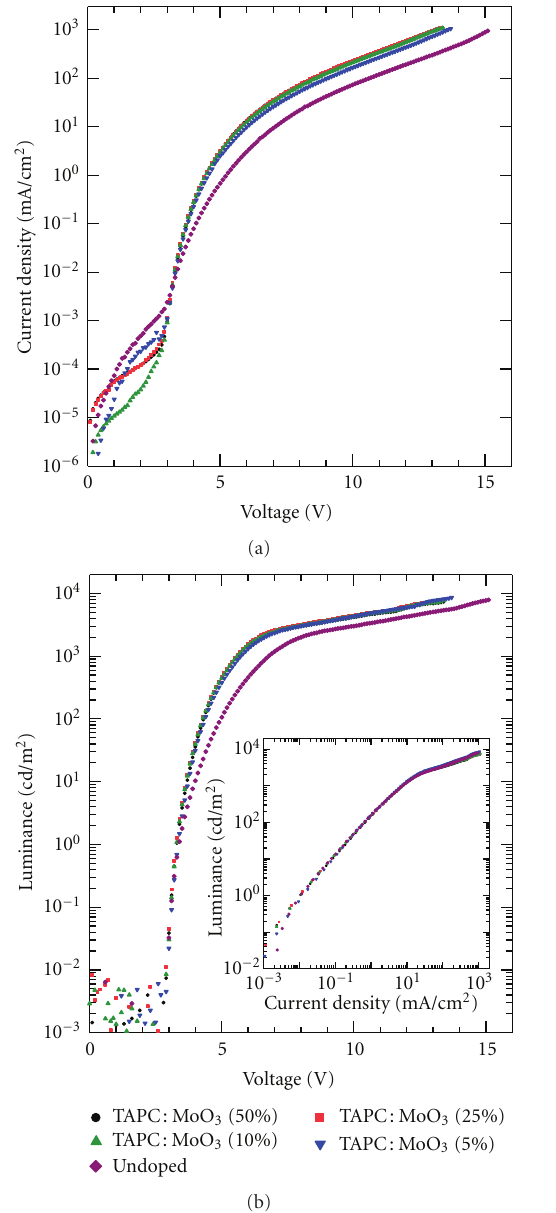
Figure 4: (a) Current density-voltage ( J - V ) and (b) luminance- voltage ( L - V ) characteristics of WOLEDs with di ff erent MoO 3 doping concentrations. Inset in (b): luminance-current density ( L - J ) characteristics from the same devices.